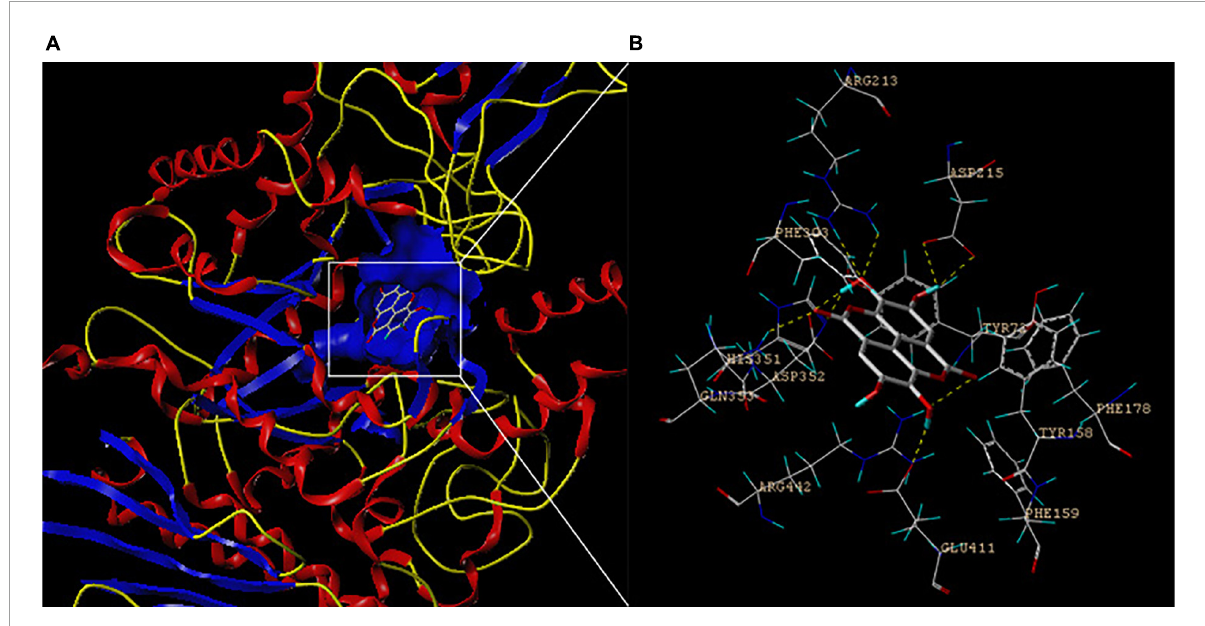
FIGURE6 The result of molecular docking between EA and α -glucosidase. (A) The active cavity of α -glucosidase was occupied by EA and (B) these interactions mainly depended on intermolecular hydrogen bonding (dashed